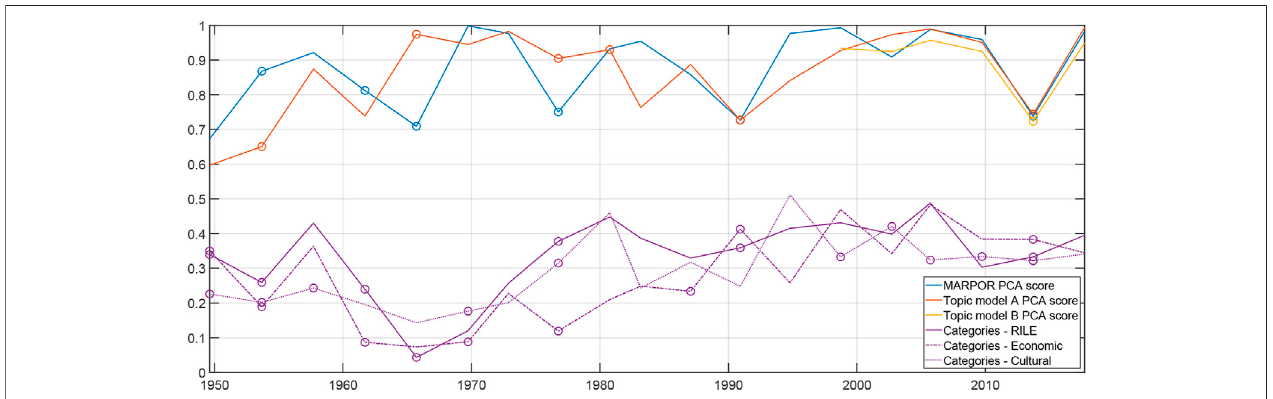
FIGURE 6| Blue, Orange, and yellow curves: Absolute values of correlations between the RILE score and the scores on principal componentsfor single elections. Political spaces were estimated from MARPOR categories (orange), topic model A (yellow) and topic model B (purple). Circles indicate cases for which not the 1st component showed the strongest correlation. Purple curve: Maximal Correlation between the RILE axis and the economic and the cultural axis of Bakker and Hobolt (2013), respectively, and a principal component for single elections. The circle indicates if it is not the fi rst principal